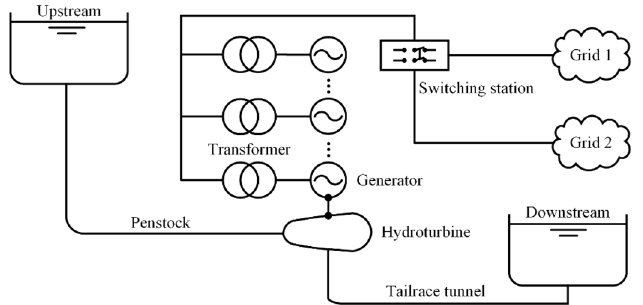
Figure 1. Schematic diagram of a hydro-turbine regulation system.